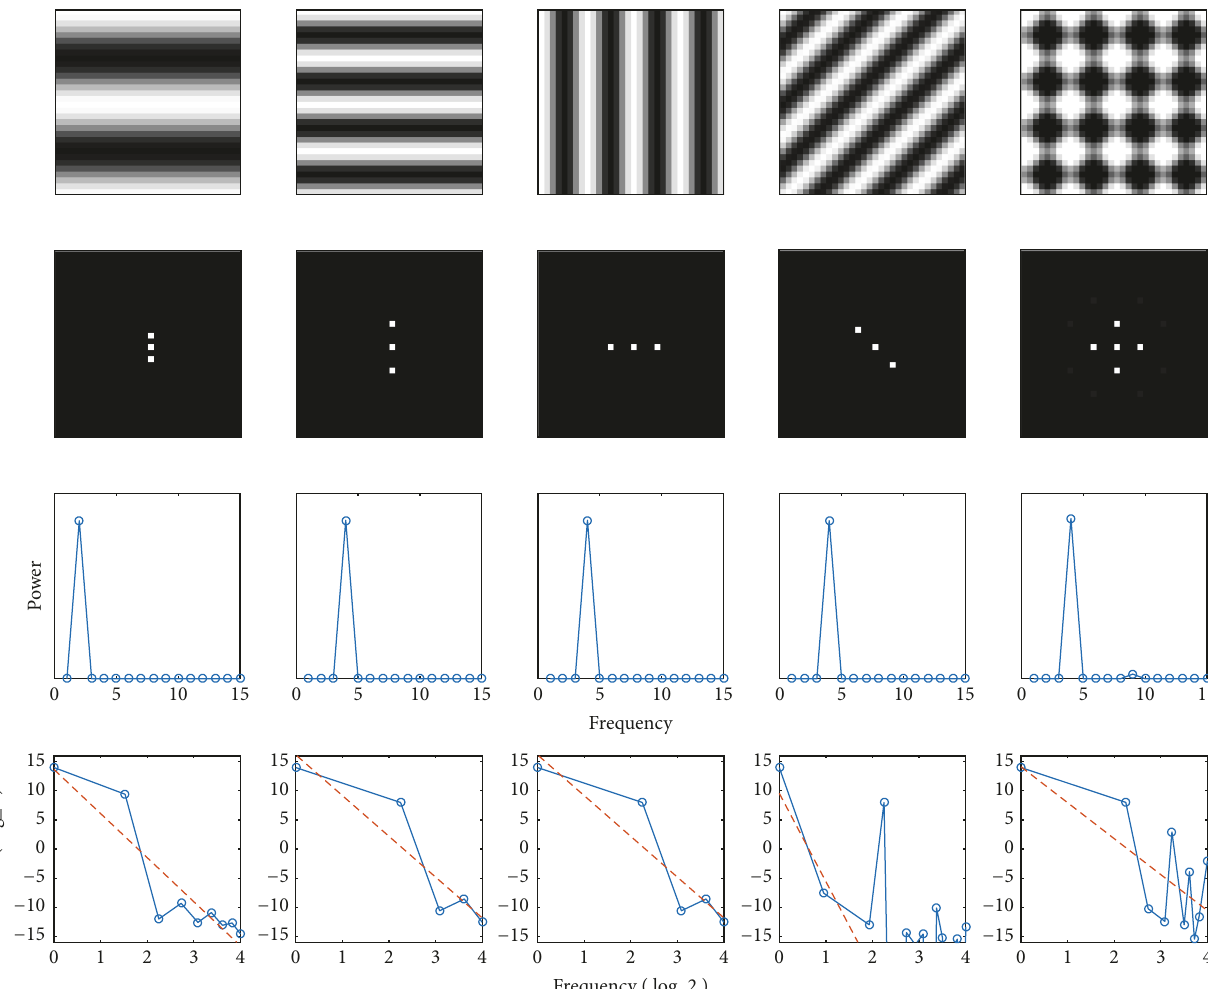
Figure 2: Power spectra interpretationand reconstruction. Rows from top to bottom: source image, shifted, and normalized constituent FFT powercoefficients,radially averagedpower spectra,and radially averagedpower spectraplotted in a log-logscale (log 2 ) with linear